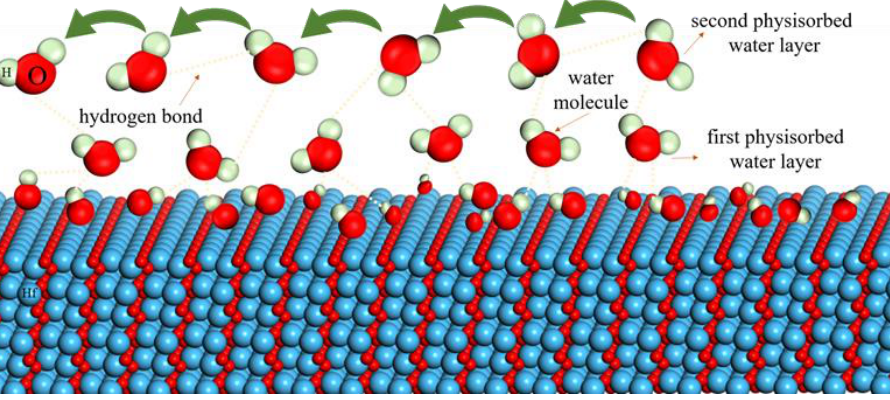
Figure 11. The sensing mechanism diagram of the sensor.